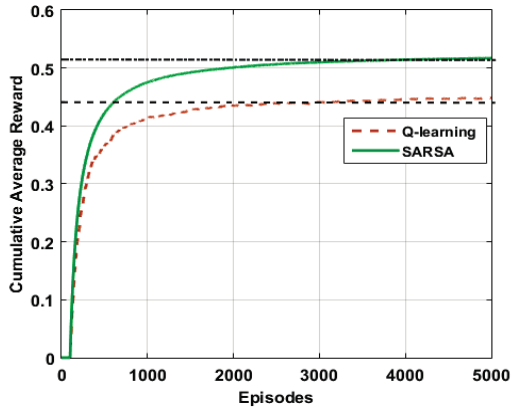
Figure 8. Expected cumulative rewards and algorithms